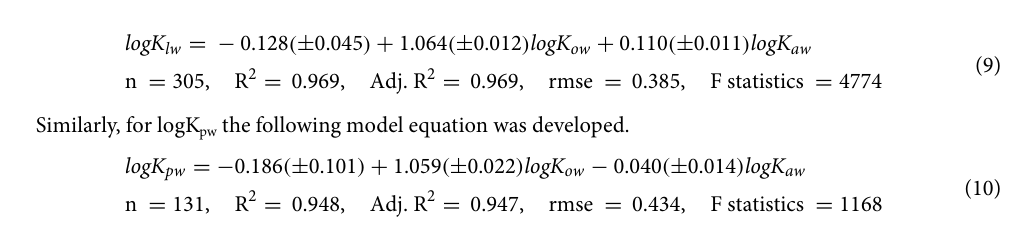
Figure 2. The application domain of tp-LFER models as evaluated by the plot of studentized residuals versus hat-values along with the Cook’s distance (which are proportional to circle size) for ( a ) storage lipid-water system and ( b ) phospholipid-water system. In panel (a) , observation numbers 168, 211, 215, 267, and 296— flagged as influential due to higher value than the critical values of either studentized residual or hat or Cook’s distance—correspond to pentadecane, 2,4-dinitrotoluene, hexadecane, 2,2,3,3,4,4,4-heptafluoro-1-butanol, and benzo[a]pyrene, respectively. In panel (b) , observation numbers 116, 124, and 125, which are flagged as influential, correspond to 3,4-dinitrophenol, estradiol, and estriol,